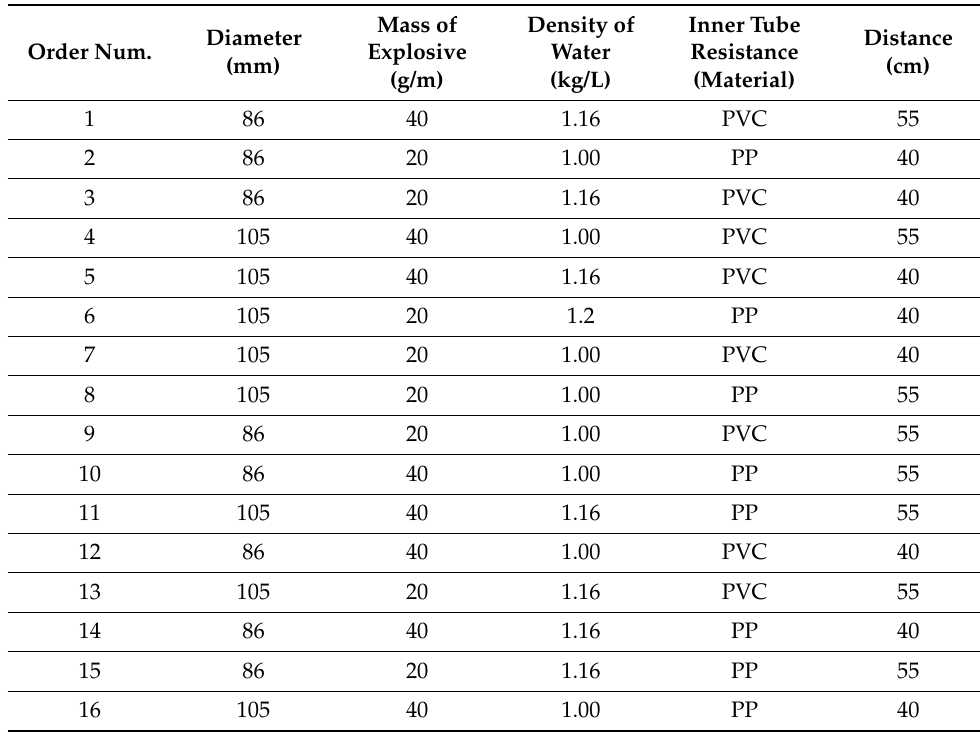
Table 2. Design of the plan of experiments carried out.